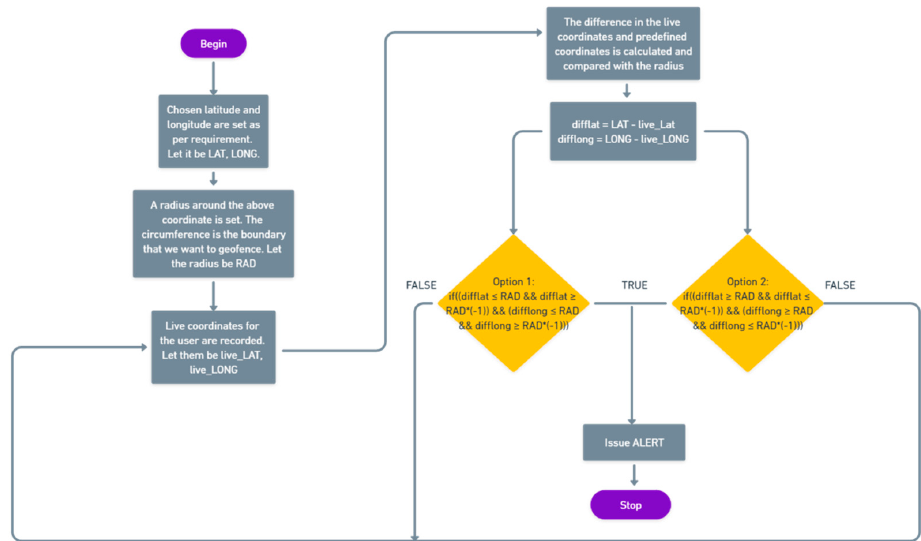
Figure 6. Flow chart for geofencing logic of the system .